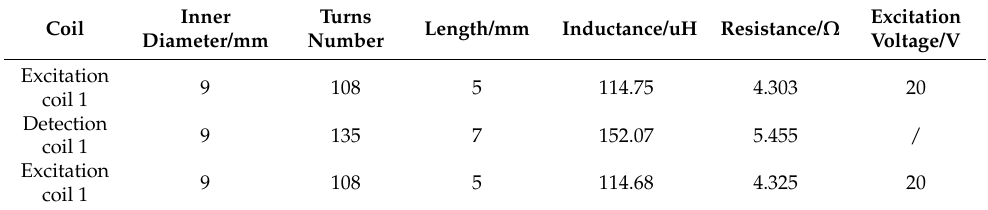
Table 1. Coil parameters.